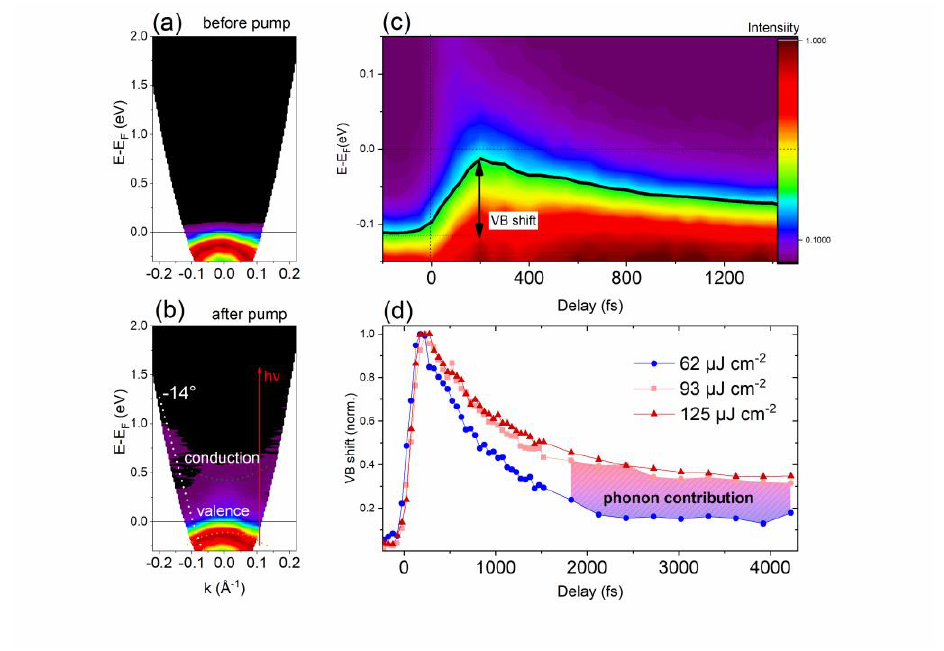
Fig. 1. trARPES maps of 1T-TiSe 2 before (a) and at 50 fs after (b) photo-excitation. In (b) the red arrow shows the direct optical transition, the conduction band is clearly populated and the -14° angle (white dashed line) represents where the VB dynamics is extracted. (c) Valence band (VB) dynamics as a function of the pump-probe delay. The solid black curve shows the transient variations of VB maximum in the first 1.5 ps, a clear evidence of the photo-induced CDW phase melting. (d) Normalized VB dynamics as a function of the pump-probe delay for different pump fluences from 62 to 125 μJ/cm 2